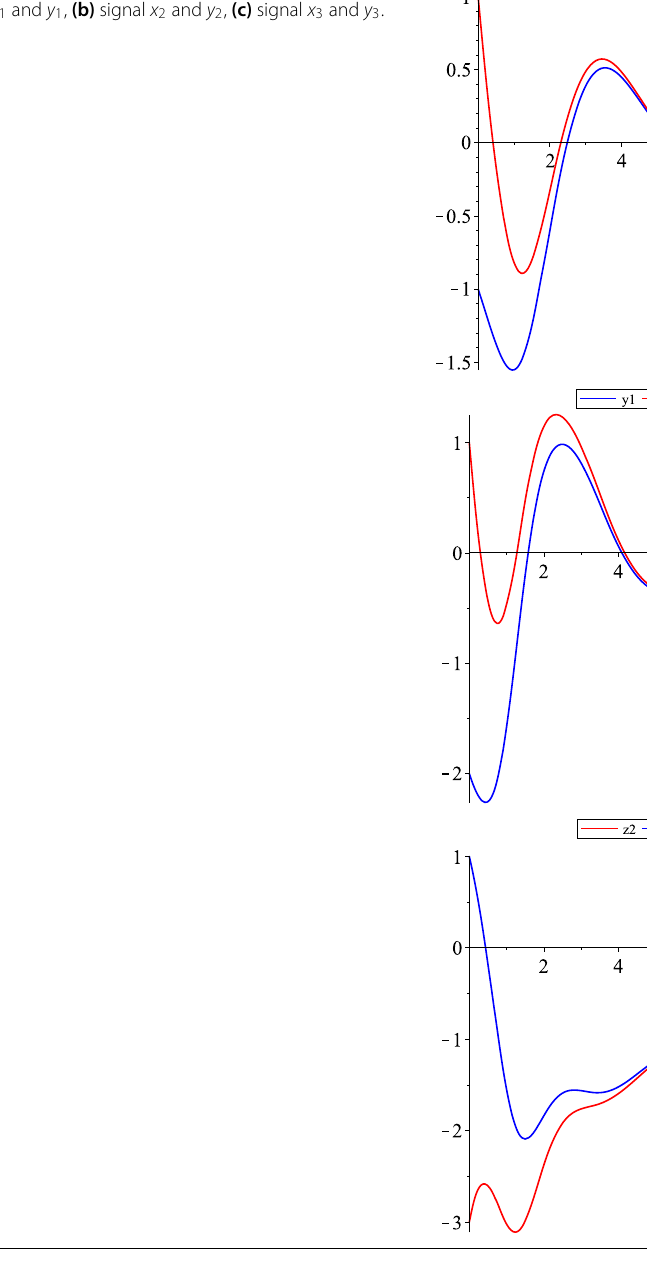
Figure 5 Solution of the two active identical Wang systems with nonlinear control. (a)